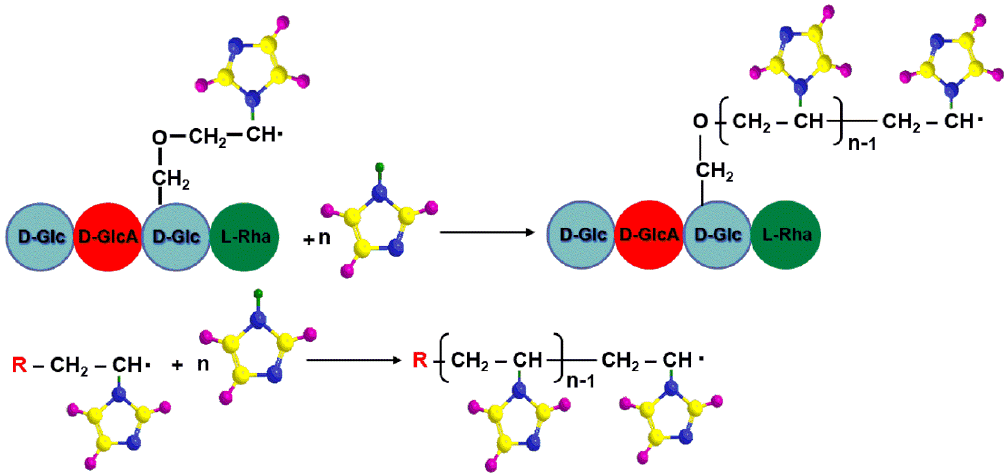
Figure 6. Propagation step of grafting copolymerization.